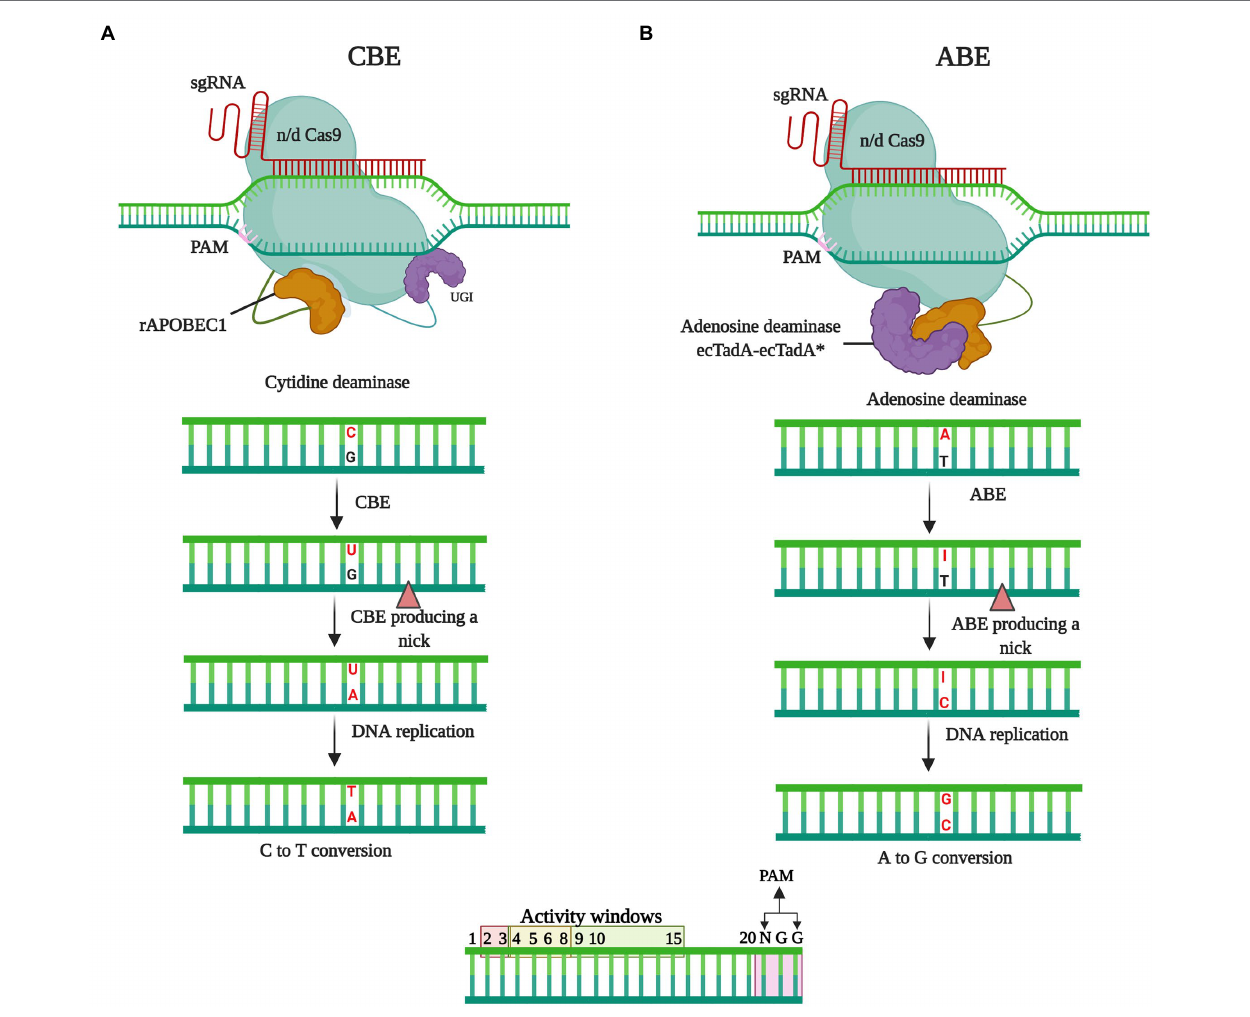
FIGURE 4 | The mechanisms of base editing. In the absence of double-strand breaks (DSBs), base editing facilitates the introduction of precise point mutations at specified target sites in the genome via nucleotide substitution. (A) Cytidine deaminase base editing (CBE) is performed in conjunction with the use of an APOBEC1 cytidine deaminase, which converts C to U. Subsequently the U-G mismatch is resolved via cellular mismatch repair or base editing mismatch repair machinery that leads to the formation of T-A at the target locus. (B) The adenine base editing (ABE) leads A-T to G-C substitution. After recruiting to the targeted genomic locus, the ABE delaminates targeted A base to I (inosine) leading to I-T base pairing. The cellular mismatch repair mechanism or DNA replication resolves the I-T, forming G-C base